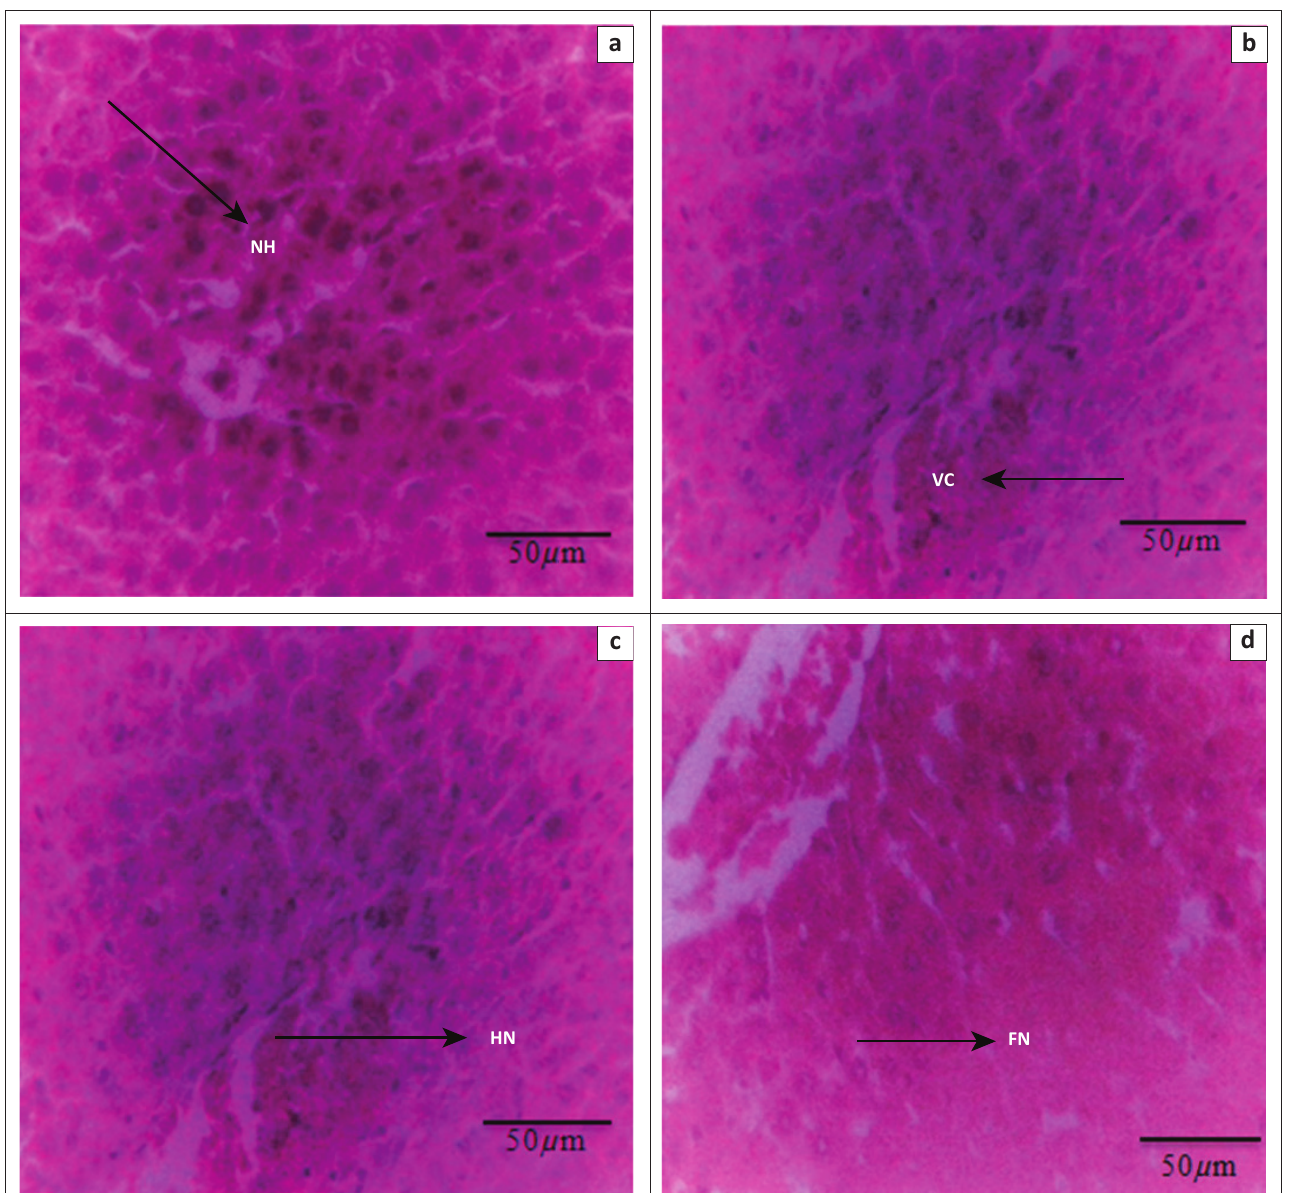
FIGURE 3: Photomicrograph of the liver section of (a) control group rats (1 mL/kg distilled water) showing normal hepatocytes; (b) after a dose of 100 mg/kg of ethanol extract of Irvingia gabonensis root bark showing vascular congestion; (c) 200 mg/kg of ethanol extract of Irvingia gabonensis root bark showing a slight hepatic necrosis; (d) 400 mg/kg of ethanol extract of Irvingia gabonensis root bark showing a moderate foci necrosis (haematoxylin and eosin stain; original magnification